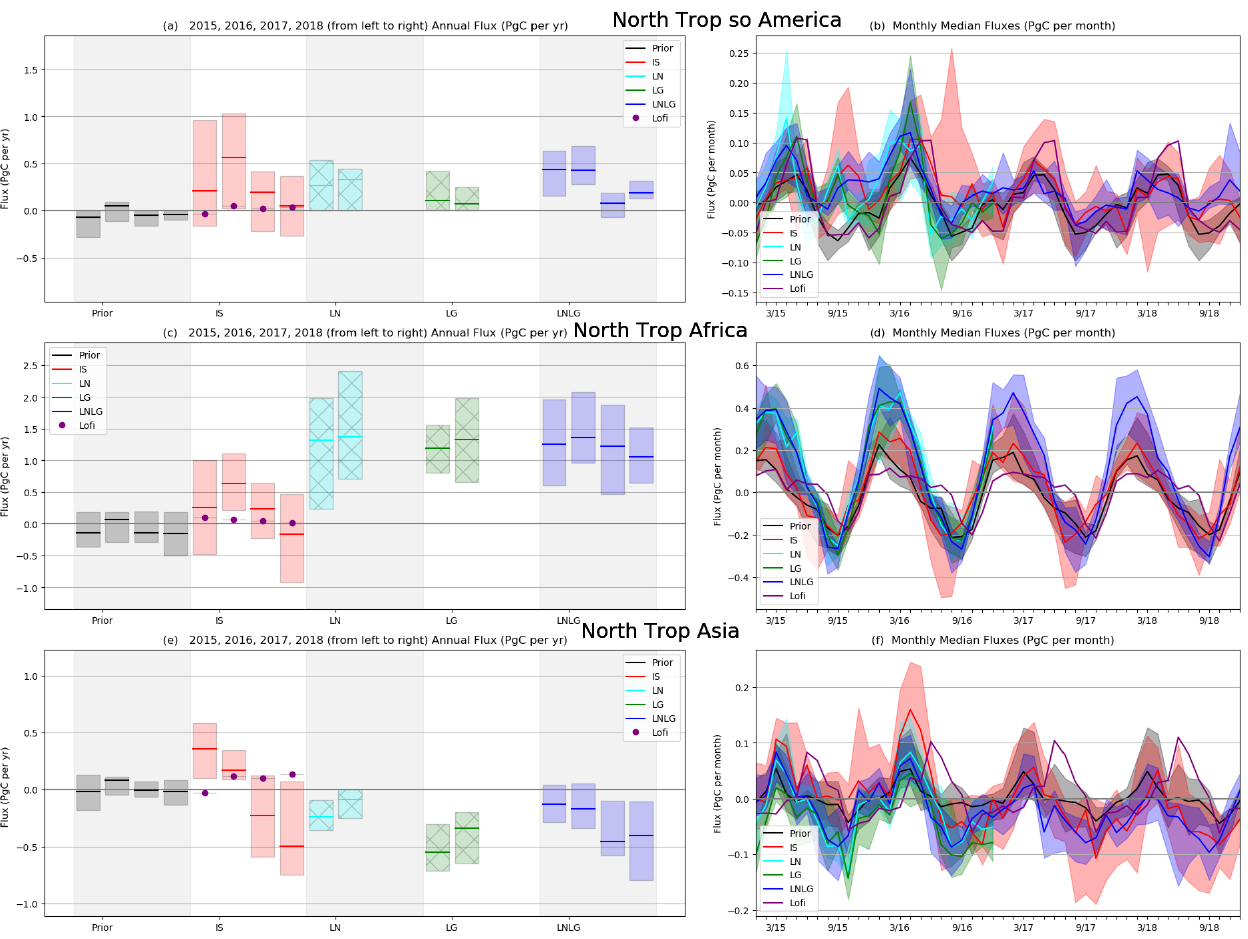
Figure 10. Same as Fig. 6 but for the northern tropical regions: northern tropical South (so) America (a, b) , northern tropical Africa (c, d) , and northern tropical Asia (e, f)